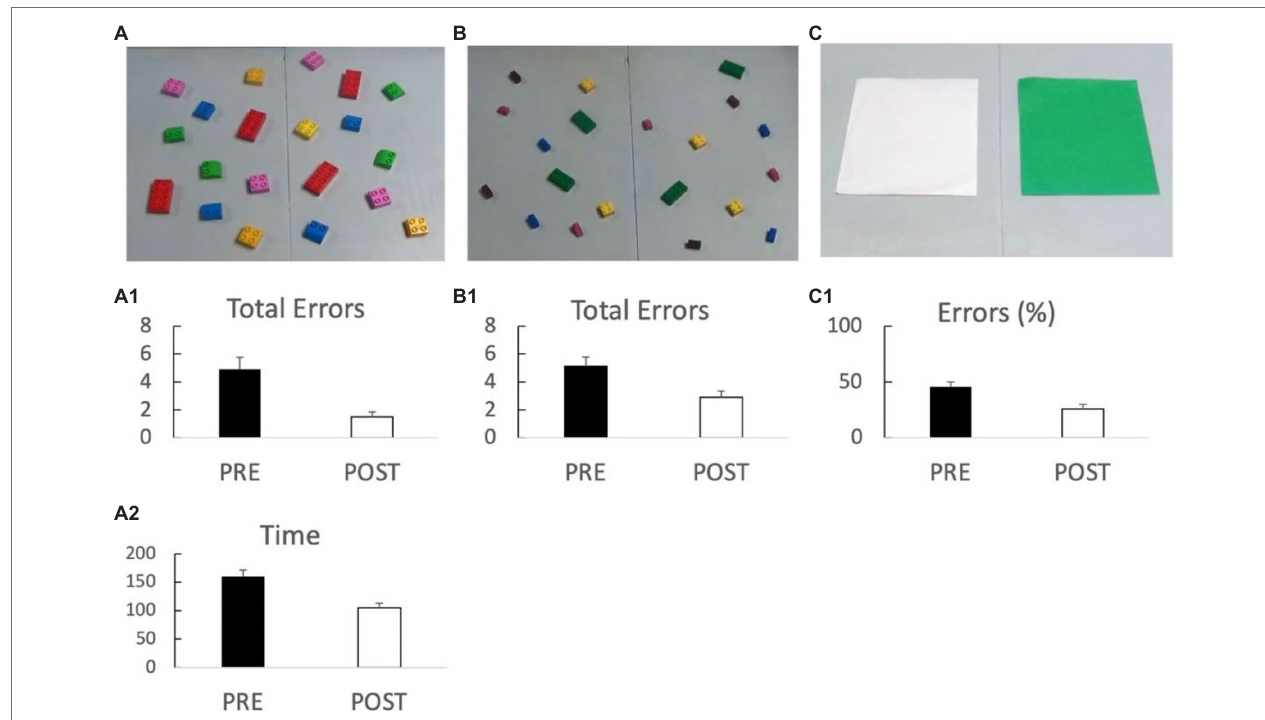
FIGURE 5 | Significant results from the Building Brains and Futures (BBF) Pre-Post-testing. Panel A shows the results of the big block task with (A.1) showing errors and (A.2) showing time to complete the task. Panel B illustrates the results of the small block task and (B.1) the errors. Panel C shows the results of the “grass or snow” task and (C.1) . the percent incorrect. In all cases, p < 0.001 Bonferroni corrected.